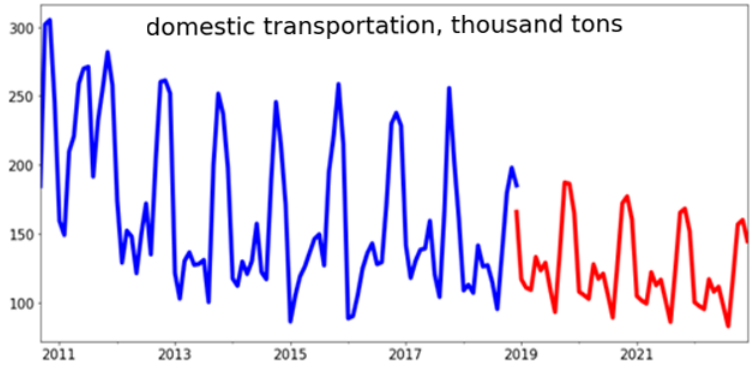
Figure 15. Building a forecast.